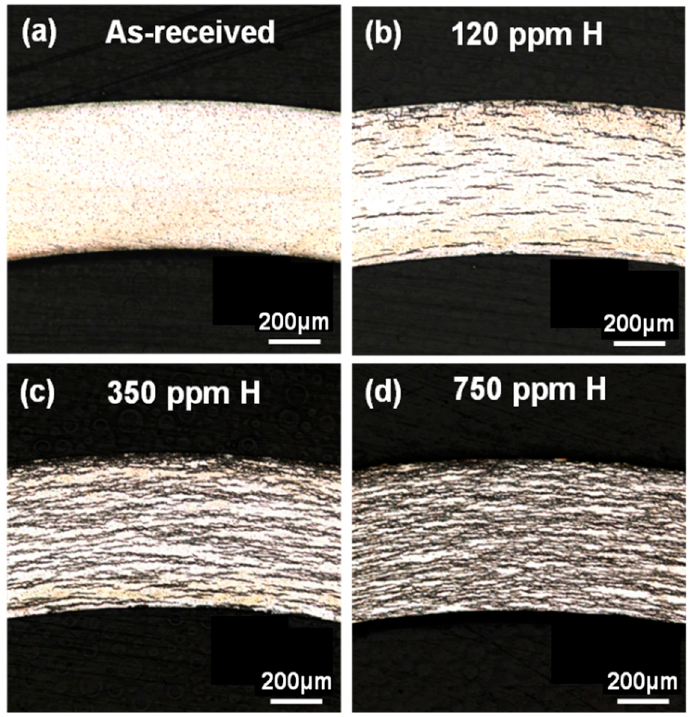
Figure 1. Optical micrographs of the ( a ) as-received Zircaloy-4 cladding, ( b ) Zircaloy-4 cladding with 120 ppm of H, ( c ) Zircaloy-4 cladding with 350 ppm of H, and ( d ) Zircaloy-4 cladding with 750 ppm of H.